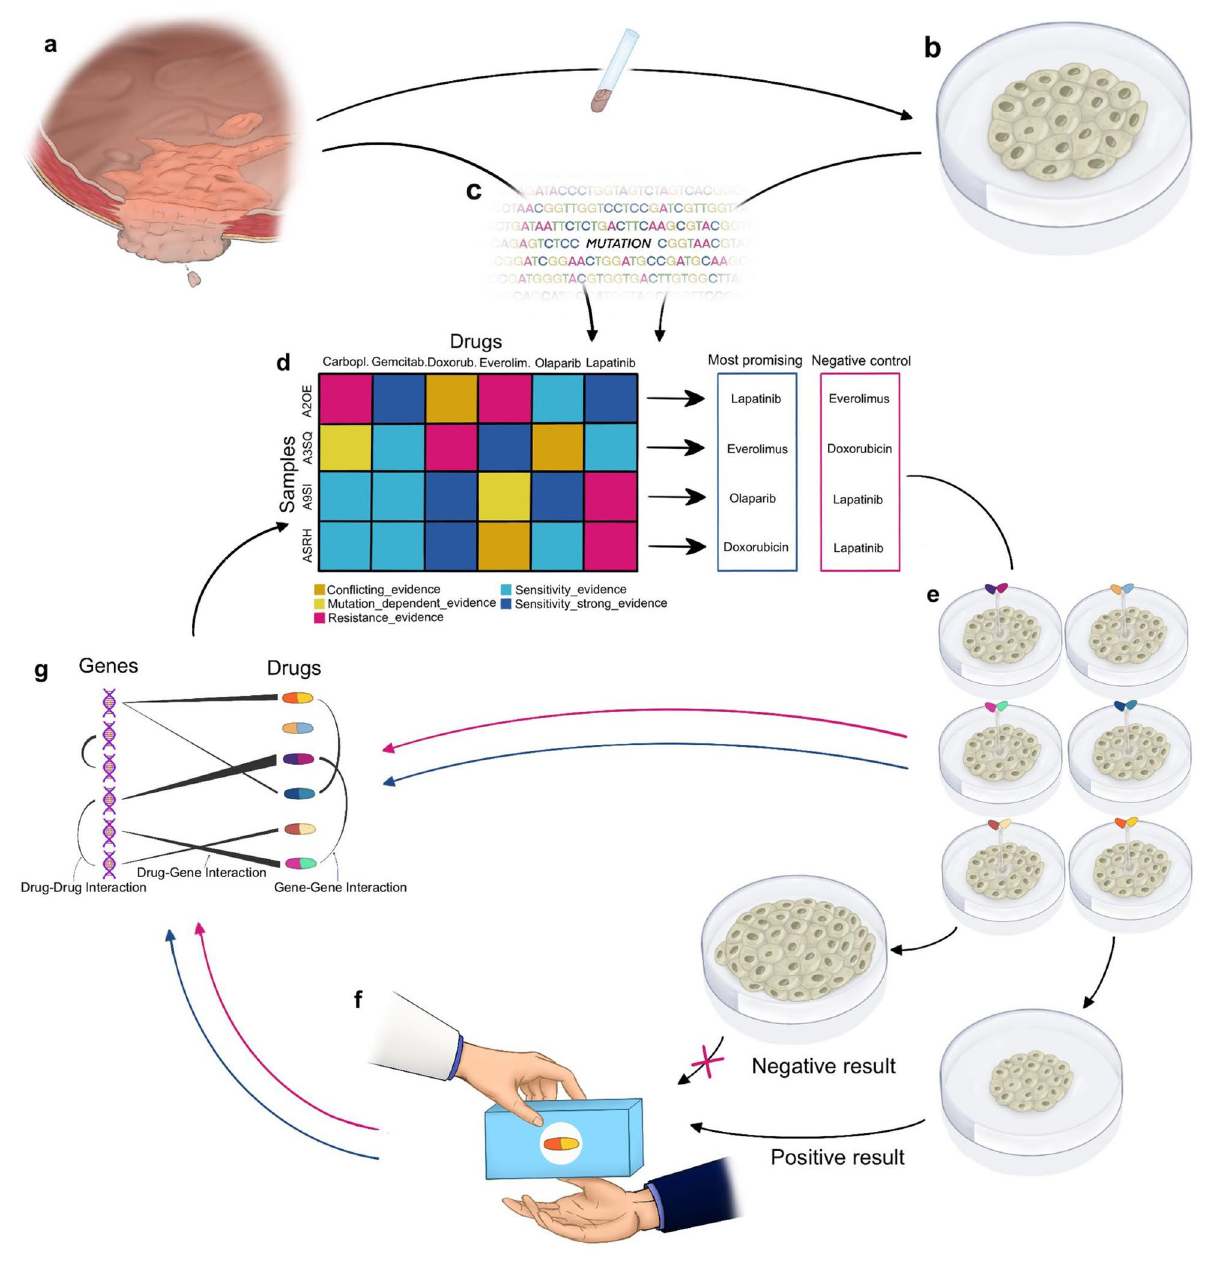
Figure 7. Blueprint for future clinical applications. ( a ) Histologic samples are derived from the tumor mass and processed into ( b ) individual patient derived tumor models. ( c ) Tumor mass and tumor models undergo sequencing to confirm genomic comparability. ( d ) Sequencing results are analyzed with our algorithm for drug response predictions. Delivering weighted (level of support) and directed (sensitivity/resistance) predictions, the most promising sensitivities can be selected to be tested against predicted resistances, functioning as negative controls. ( e ) The derived proposals are tested in the patient derived models. ( f ) The drug with the best response is administered to the patient, while feedback about in vitro sensitivities and resistances is reported to the database. ( g ) Clinical response is also reported to databases (DGIdb; CIViC etc.), increasing or decreasing the power of the DGIs for the next query of the algorithm. (Procreate, Version X, https ://procr